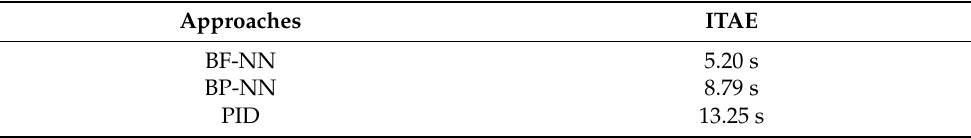
Table 4. ITAE for BF-NN, BP-NN, and PID